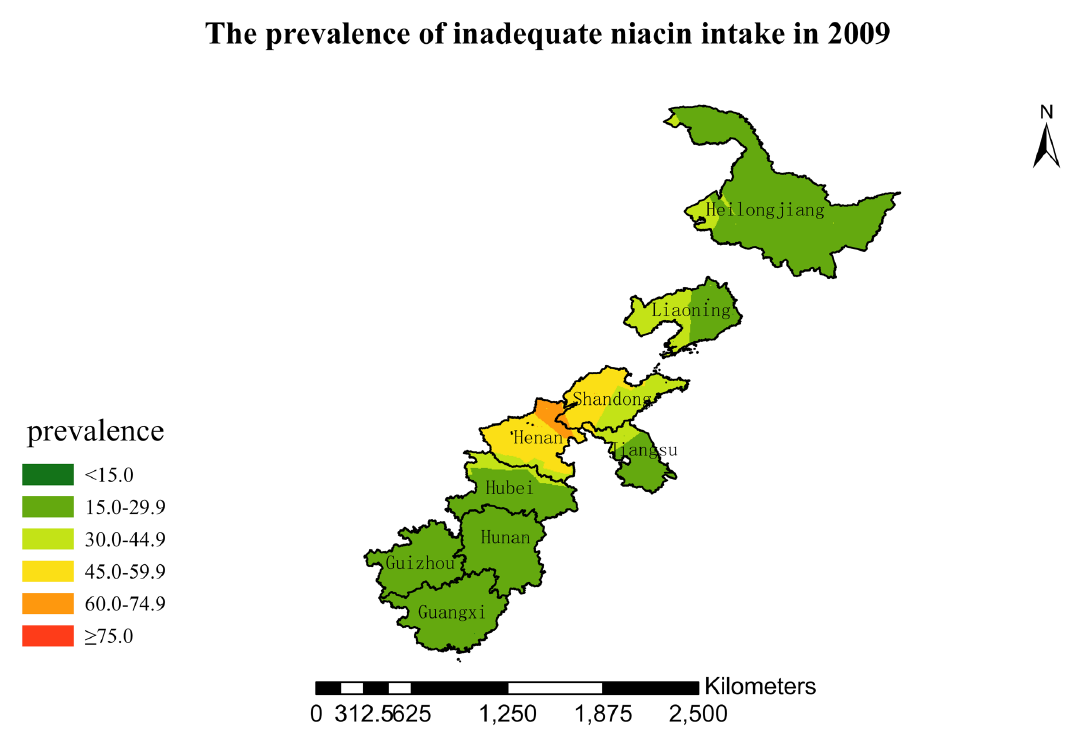
Figure 7. The prevalence of inadequate niacin intake by county in 2009 among Chinese Residents ≥ 5 Years of Age.